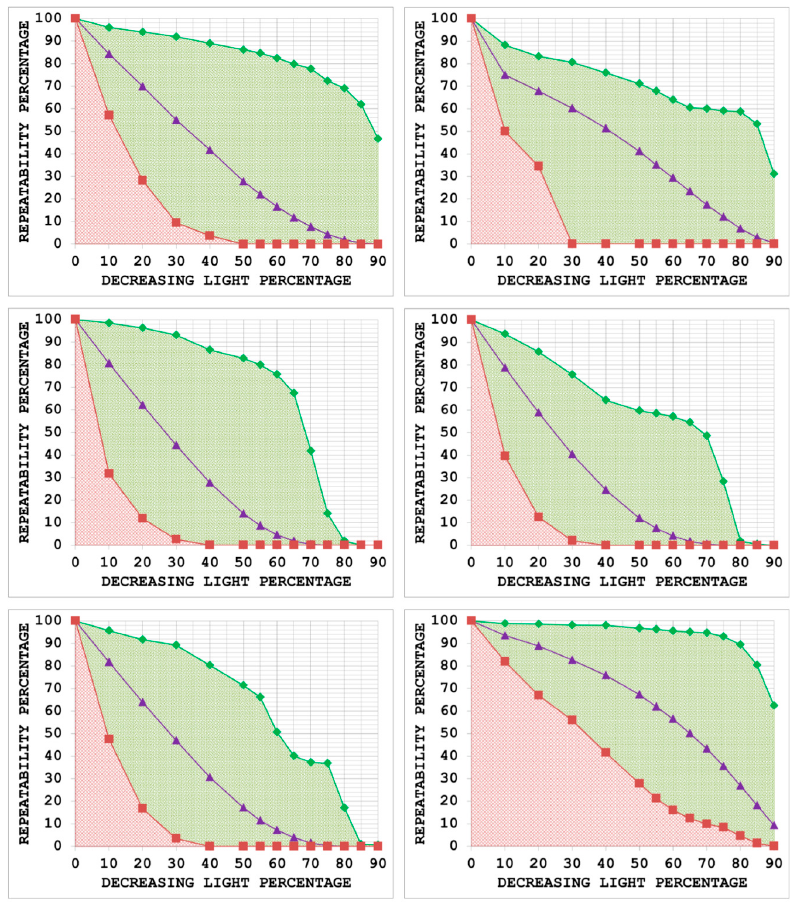
Figure 7. Results for uniform light variations utilizing the proposed framework and the image database for MSER ( top left ), IBR ( top right ), Harris-Laplace ( center left ), Hessian-Laplace ( center right ), SURF ( bottom left ) and SFOP ( bottom right ) detectors.